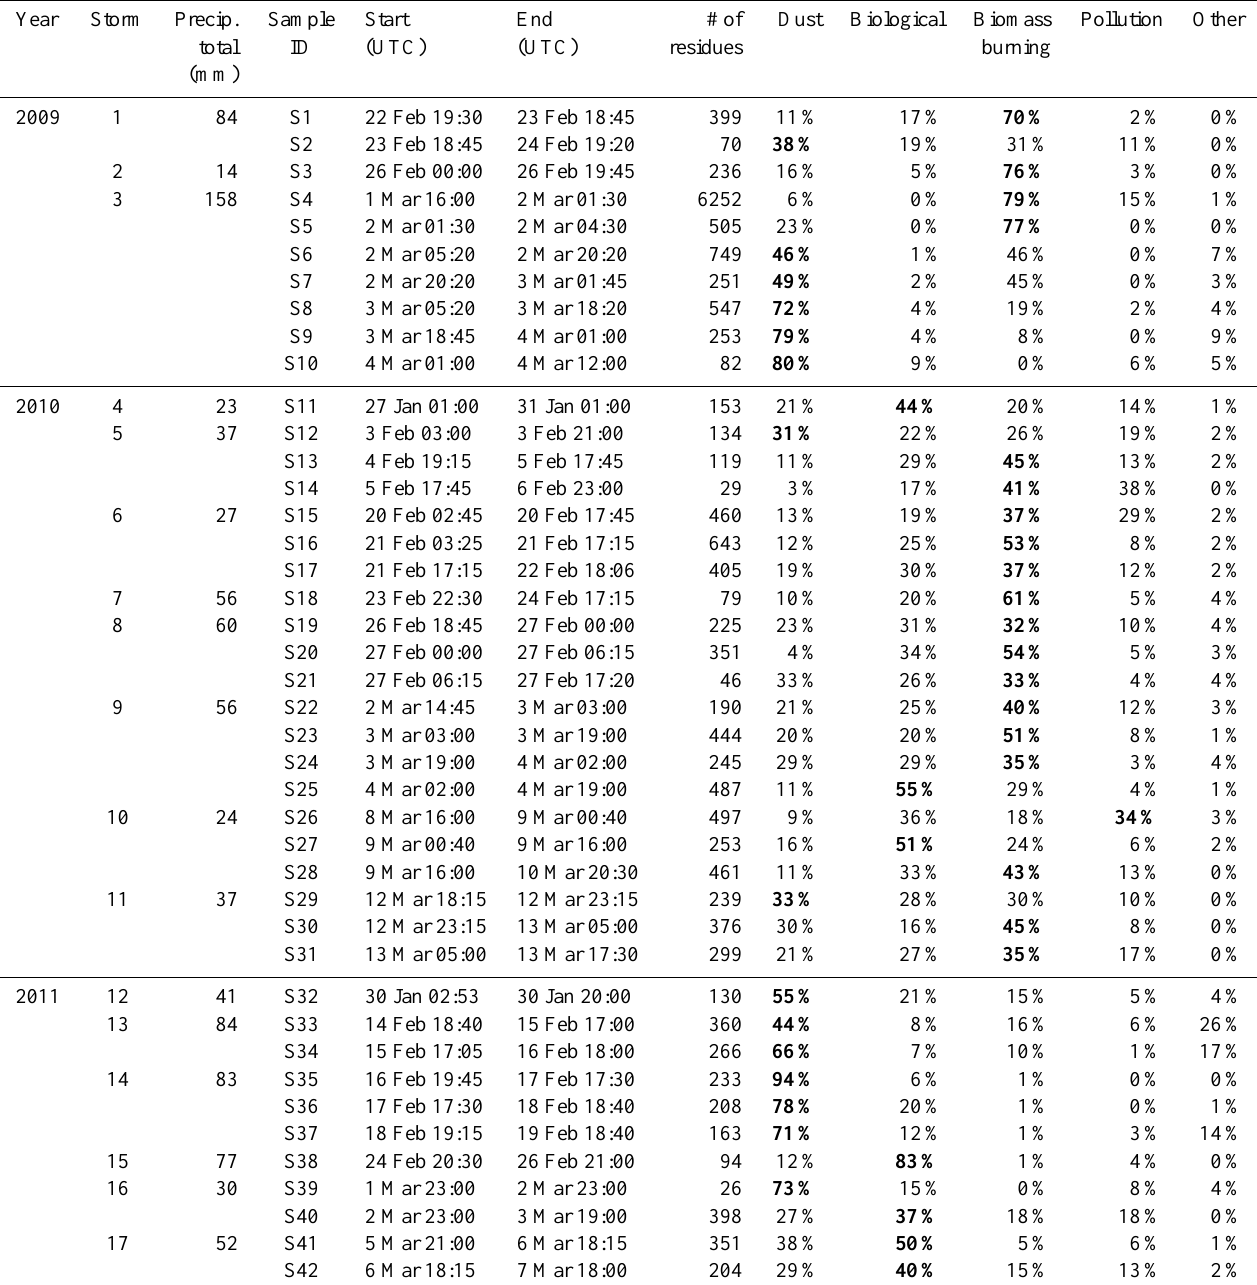
Table 1. Statistics for precipitation sample collection during storms from 2009 to 2011 at SPD. The start and end dates reflect when the beakers were placed outside; they do not always correspond to the exact start and end of falling precipitation. The percentages of each insoluble residue type per sample are provided (bolded percentages show dominant